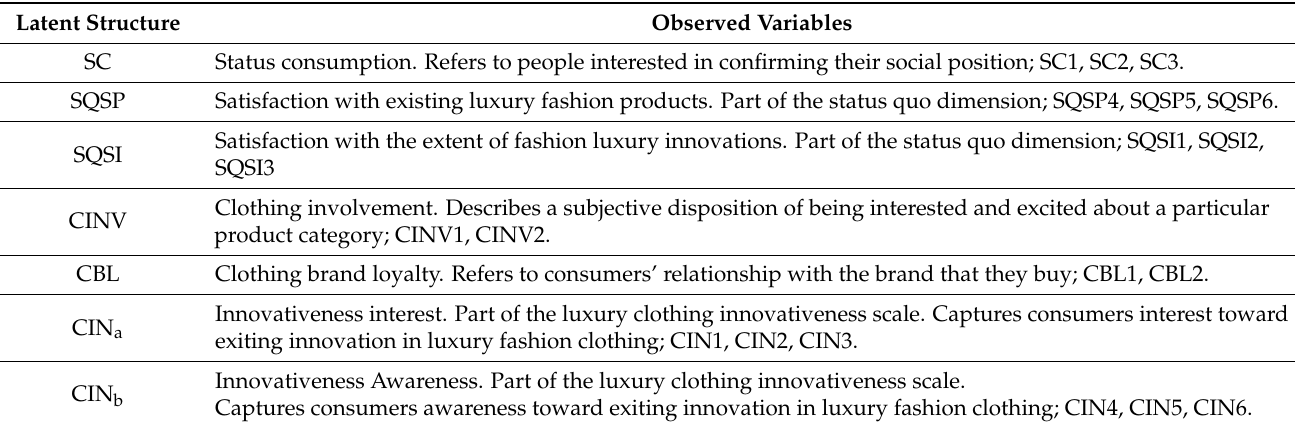
Table 5. An outline of latent predictors, with abbreviations and descriptions.